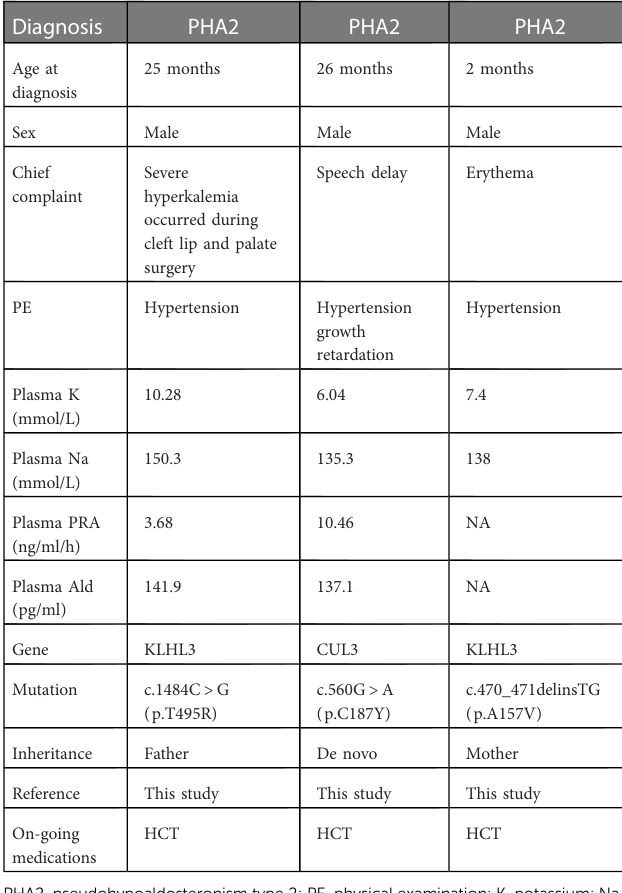
TABLE 2 Characteristics of patients with pseudohypoaldosteronism type 2.